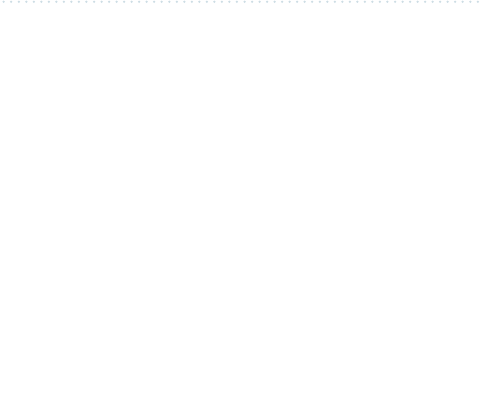
Figure 1. Schematic illustration on the preparation of Zeozyme NPs from zeolite, Lys, xylanase, and CMC polymer as the starting materials.